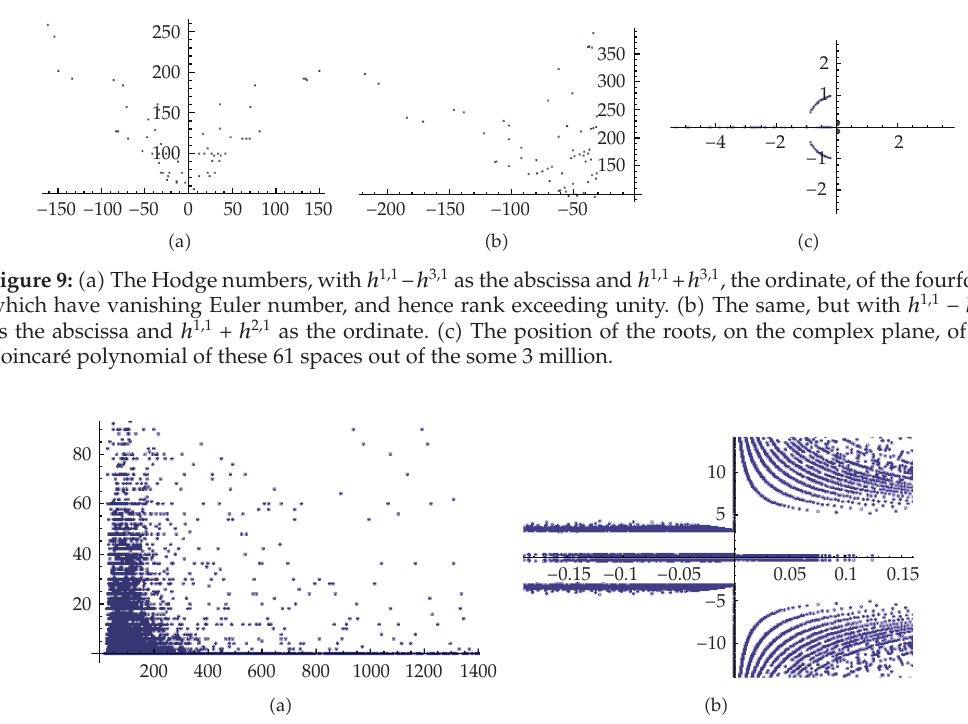
have the property that h 1 , 1 (cid:7) h 3 , 1 . We plot the pairs (cid:5) h 1 , 1 (cid:7) h 3 , 1 , h 2 , 1 (cid:6) in part (cid:5) a (cid:6) of Figure 10 and the roots of their Poincar´e polynomials in part (cid:5) b (cid:6)